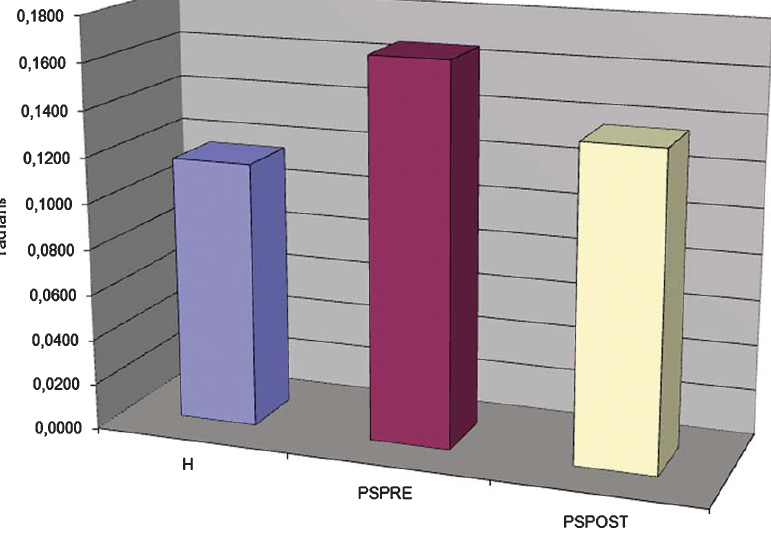
Fig. 7. Group values of parameter Mean ( (cid:1) F ) for direction S b , in P H , P PSPRE and P PSPOST .